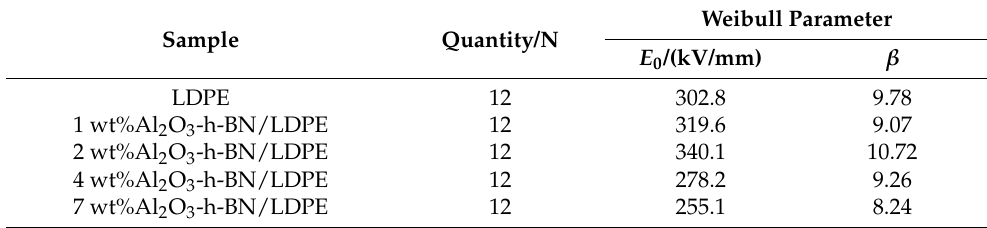
Figure 6. Weibull distribution of breakdown field intensity of pure LDPE and its nanocomposite specimens. Table 2. Variation in Weibull distribution parameters of pure LDPE and its nanoparticle-doped composite specimens.